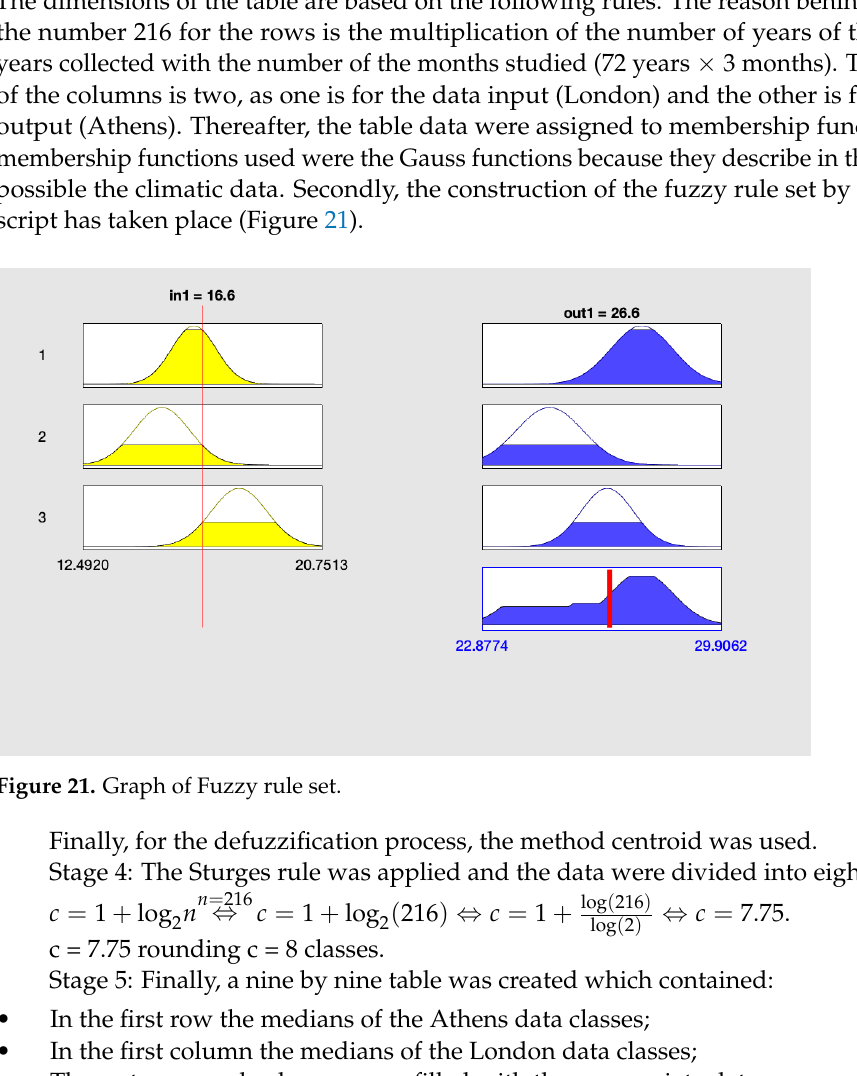
c = 7.75 rounding c = 8